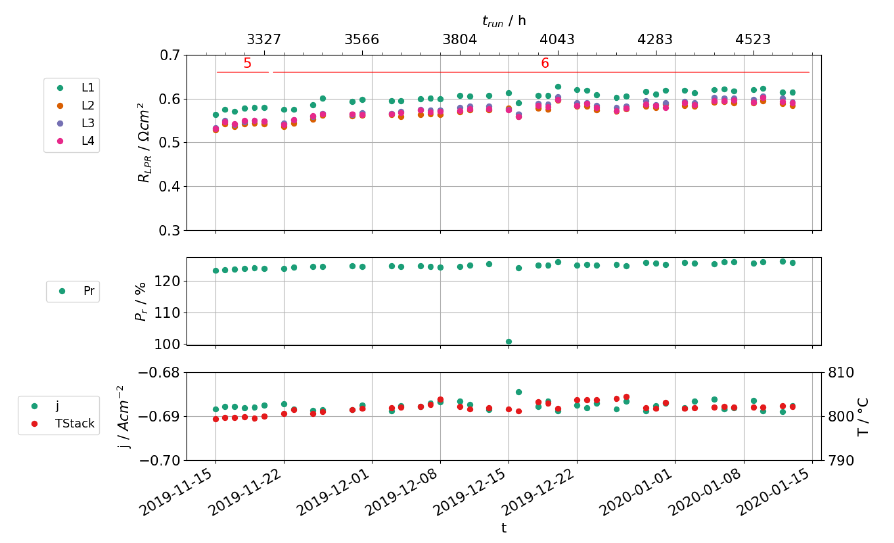
Figure 7. Daily averaged cell resistances by the LPR method (top), relative power (center), current density, and stack temperature (bottom) for stack B. Includes only the values measured at the same time as the intermittent LPR measurements, which were recorded at 0.70 A cm − 2 . The operational phases are indicated with red